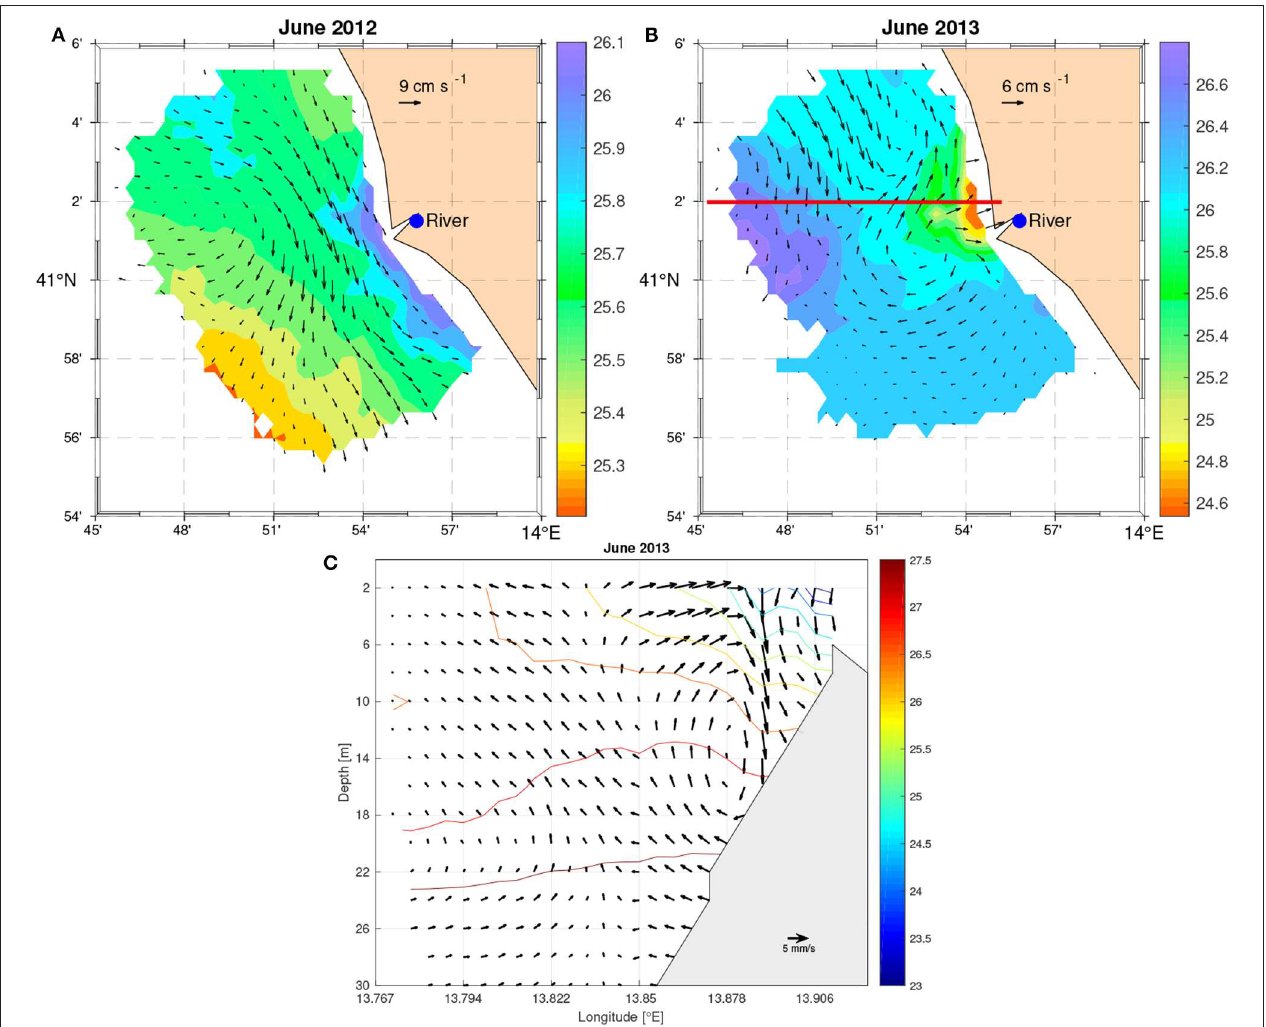
FIGURE 11 | Density and steady circulation at 5 m from the diagnostic numerical experiment using temperature and salinity fields optimally interpolated from the CTDs of June 2012 (A) and in June 2013 (B) . Units are kg m − 3 for density ( σ t ) and cm s − 1 for the total velocity, which are not plotted where the expected error of the OA on the observed temperature and salinity exceeds 20 % . Panel (C) shows the vertical velocities and the density contours at 41 ◦ 02 ′ N (red line in B